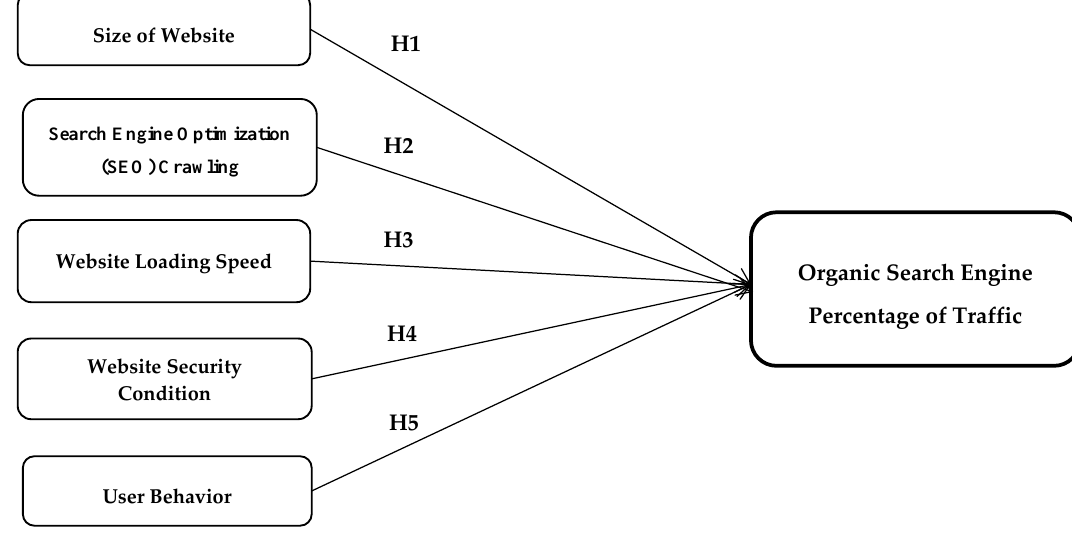
Figure 5. The proposed research model. Each of the proposed factors might have a different impact on the increase of the organic search engine percentage of traffic.